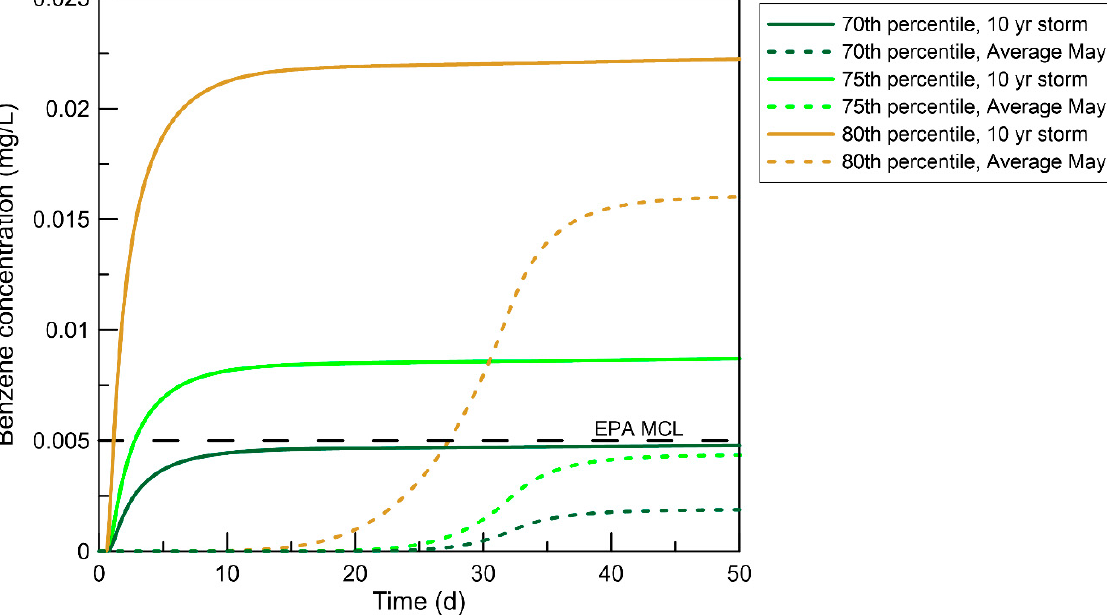
Figure 8. Benzene concentration breakthrough curves for a 2 ft water table and conservative transport with precipitation events immediately following the spill. This plot compares the 10 year storm to an average May, with the same total precipitation depth but different precipitation rates.